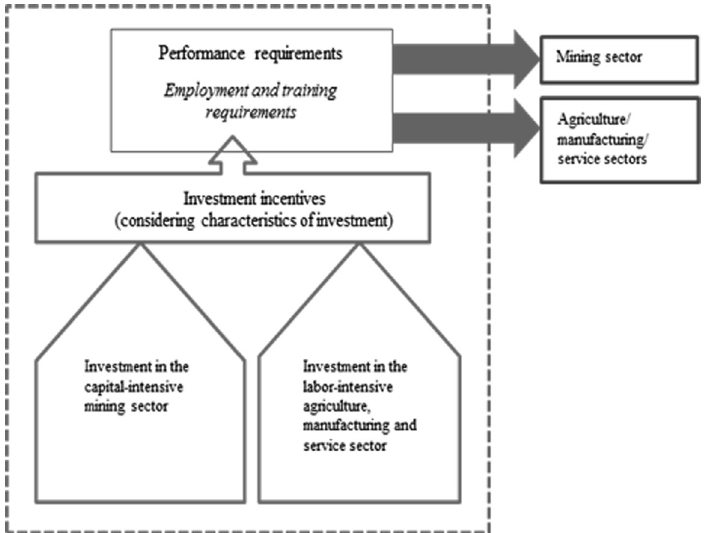
Figure 1. Option one: Using performance requirements and investment incentives